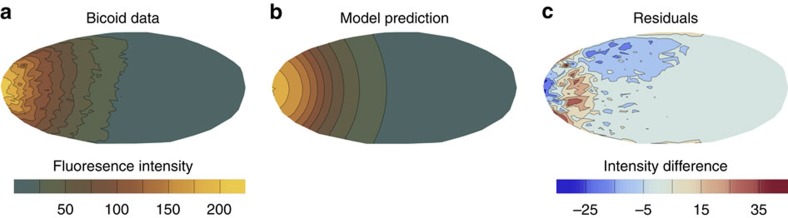
Results for the Drosophila embryo bicoid data.(a) Measurement data of bicoid fluorescence intensity across a single embryo. (b) Corresponding prediction of our point process model. (c) Difference of the experimental data and point process prediction. We observe the point process prediction agrees well with the experimental data. The point process prediction is obtained by solving equation (4) numerically for the inferred parameter values maximizing the data likelihood.